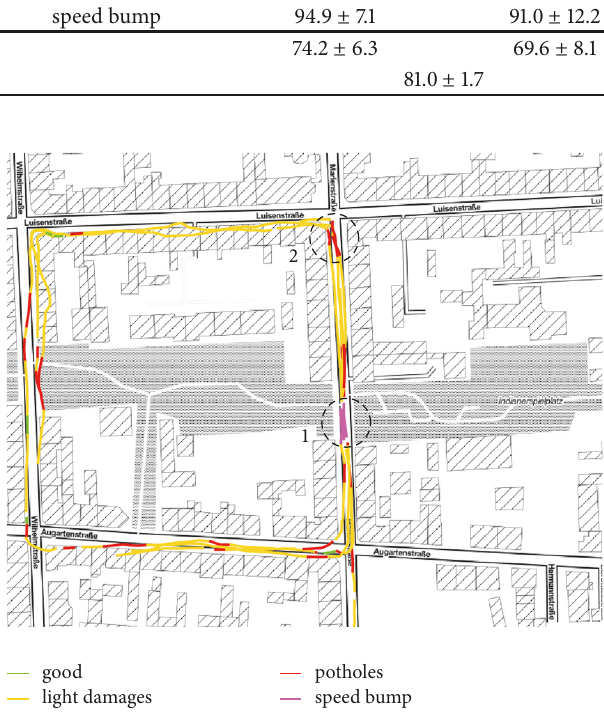
Figure 7: Event classification results for road segments in the city of Karlsruhe, Germany.